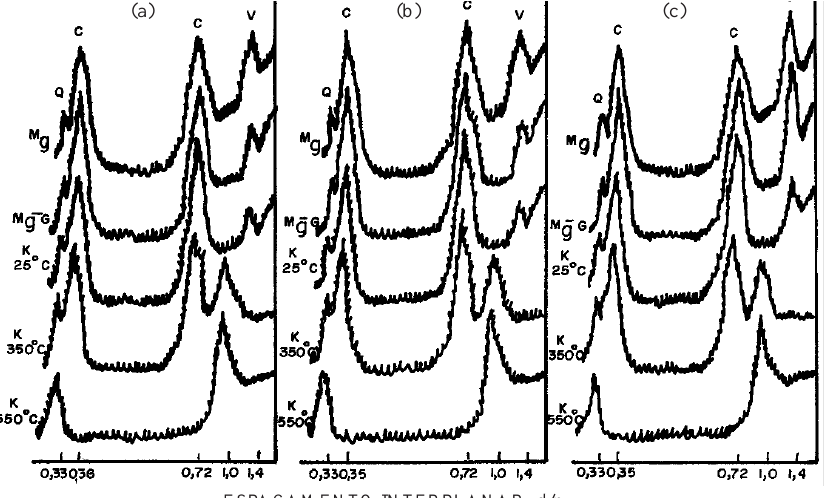
Figura 2. Difratogramas da fração argila do perfil 2 (PVAe). (a) horizonte AB; (b) horizonte 2Bt2 e (c) horizonte 2BC. Q: quartzo; C: caulinita; V: vermiculita.Valores de d/n em